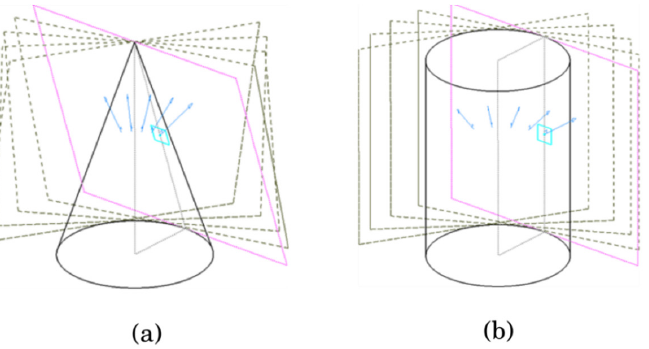
Figure 10. A different shape of the set of planes, ( a ) Cone shape, ( b ) Cylinder shape.